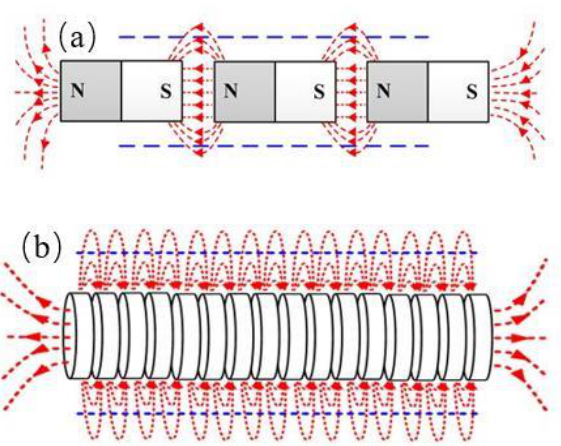
Figure 3. The distribution of the magnetic lines of combined bar magnets. ( a ) Three bar magnets; ( b ) multiple bar magnets .